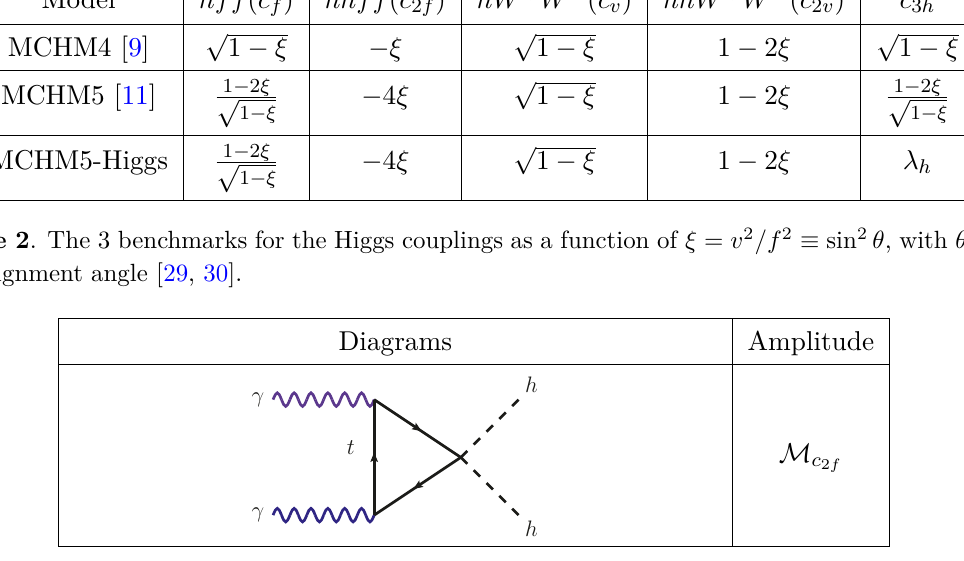
Table 3 . Additional diagram in minimal composite Higgs models, with the corresponding partial